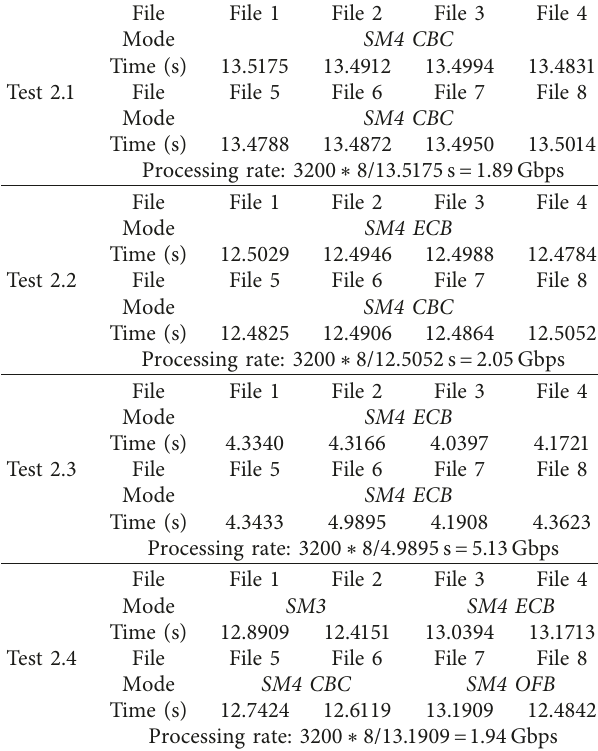
Table 2: Cipher operation time under cross